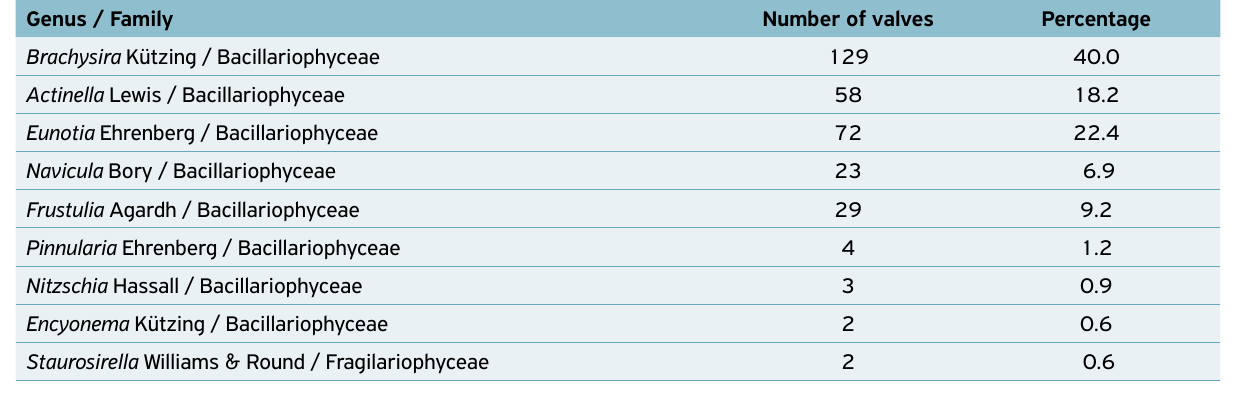
Table 2. Diatom genera present in Poultry Sec ® (× 40